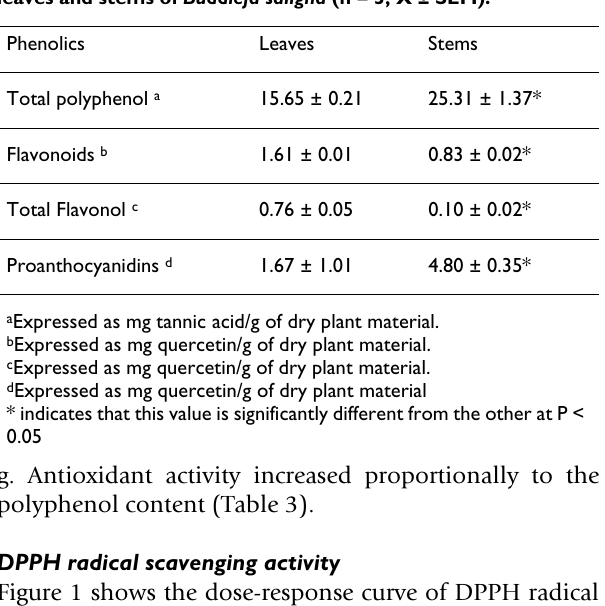
Table 3: FRAP activity of the leaves and stem extracts of Buddleja saligna Extracts FRAP e Leaves